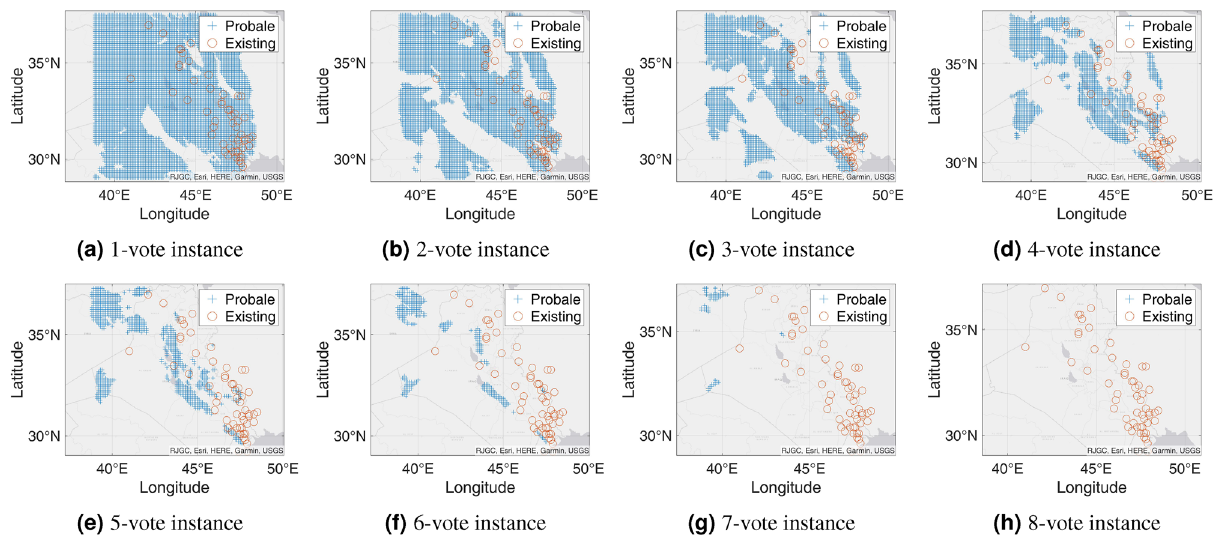
Figure 16. Probable petroleum deposits based on the existence of 1 to 8 votes over our eight best-performing models found from the graph-based analysis for the new testing dataset from Harvard (the figures are created using MATLAB 2021a 51 ).